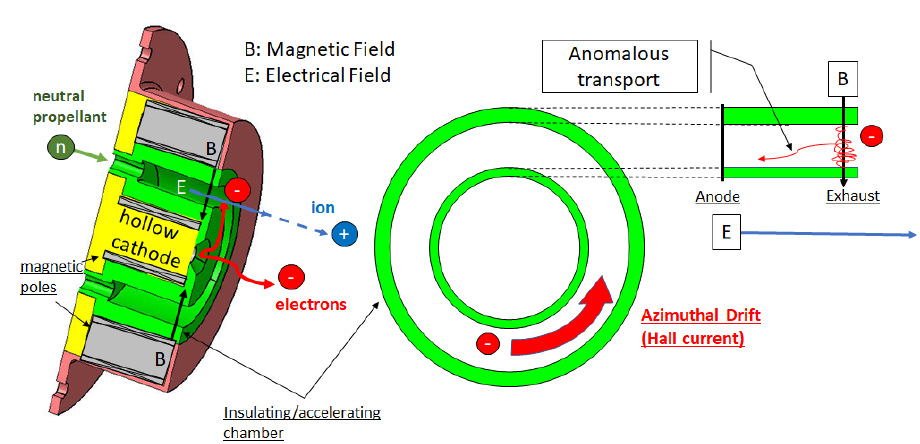
Figure 1. A scheme illustrating a Hall Effect Thruster and its principles of